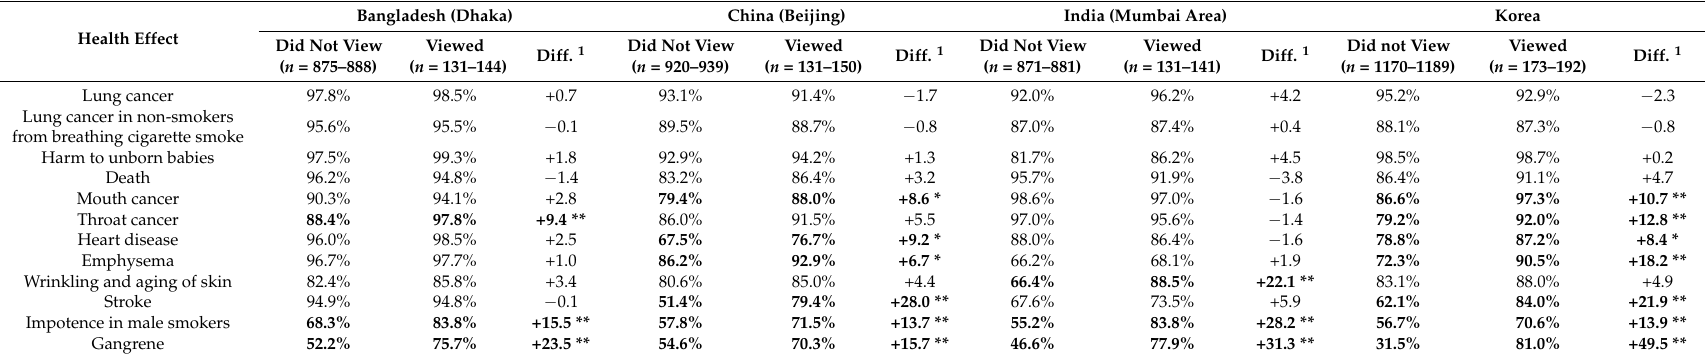
Table 3. Percentage of respondents in each country sample who believed that smoking causes each of 12 health effects, by whether the relevant warning set was viewed during the